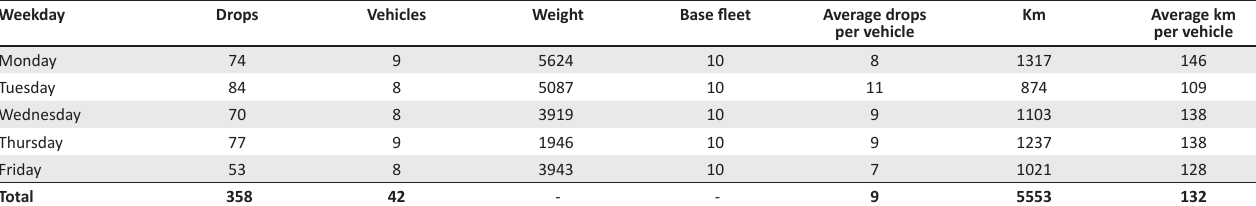
TABLE 8: Distribution centre 4 plan case study optimisation